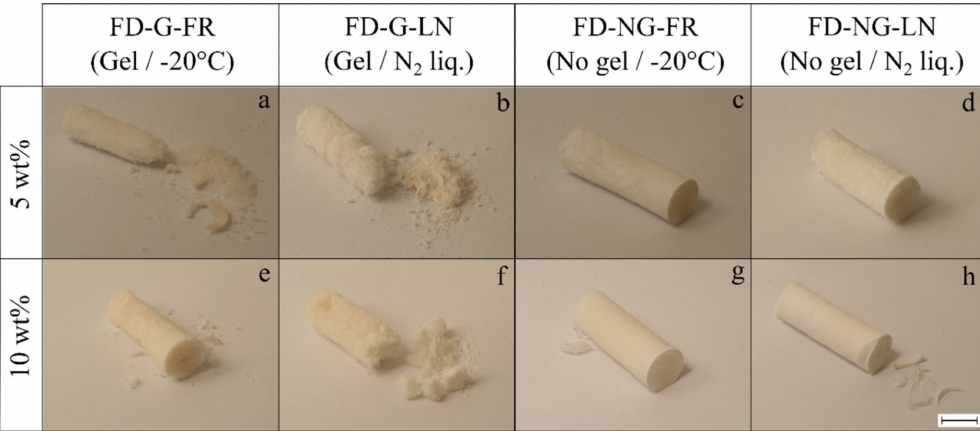
Figure 2. Physical appearance of freeze-dried starch samples (“FD”) derived from 5 and 10 wt.% starch suspensions corresponding respectively to the first and second row of pictures ( a – d ) and ( e – h ). Samples gelled and retrograded at +6 ◦ C overnight are denoted as “FD-G” (pictures ( a , b , e , f )), non-gelled samples are denoted as “FD-NG” (pictures ( c , d , g , h )). Prior to freeze-drying the samples were frozen at − 20 ◦ C in a freezer (“FR”—pictures ( a , e , c , g )) or in liquid nitrogen (“LN”—pictures ( b , f , d , h )). Sublimation was performed at 2.38 mbar (cold trap temperature − 10 ◦ C) for 48 h. The scale bar corresponds to approximatively 1